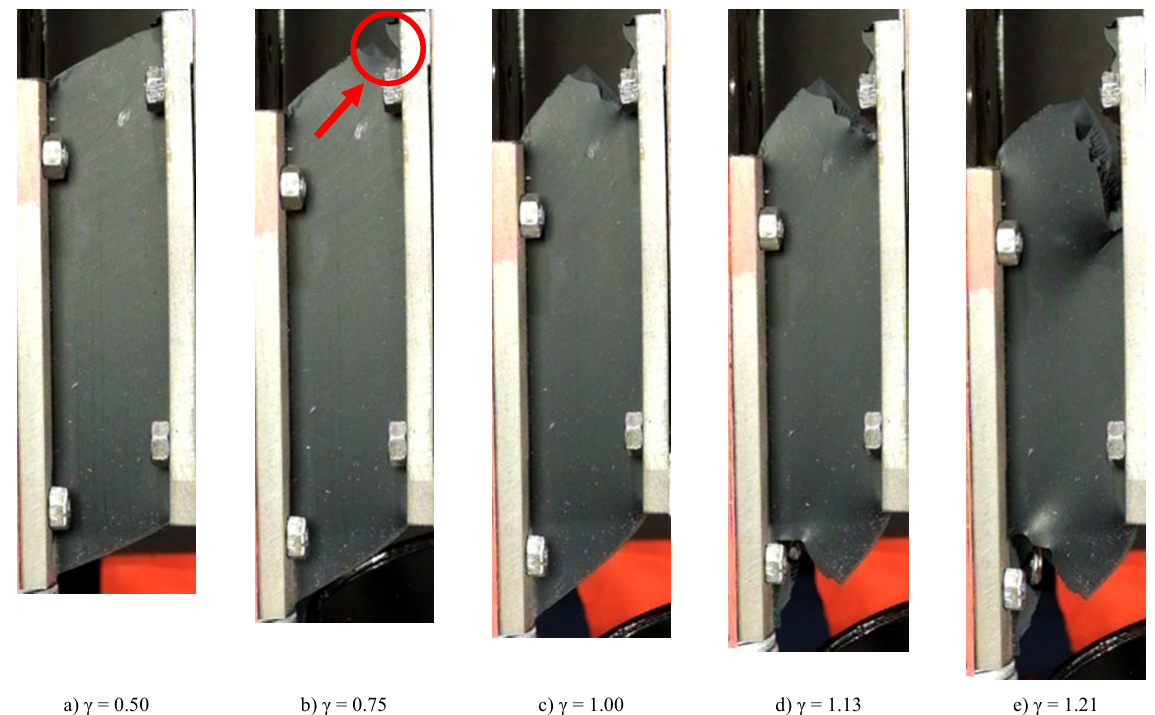
a) γ = 0.50 Fig. 14 Observed deformations for the points given in figure 13. γ is the engineering shear